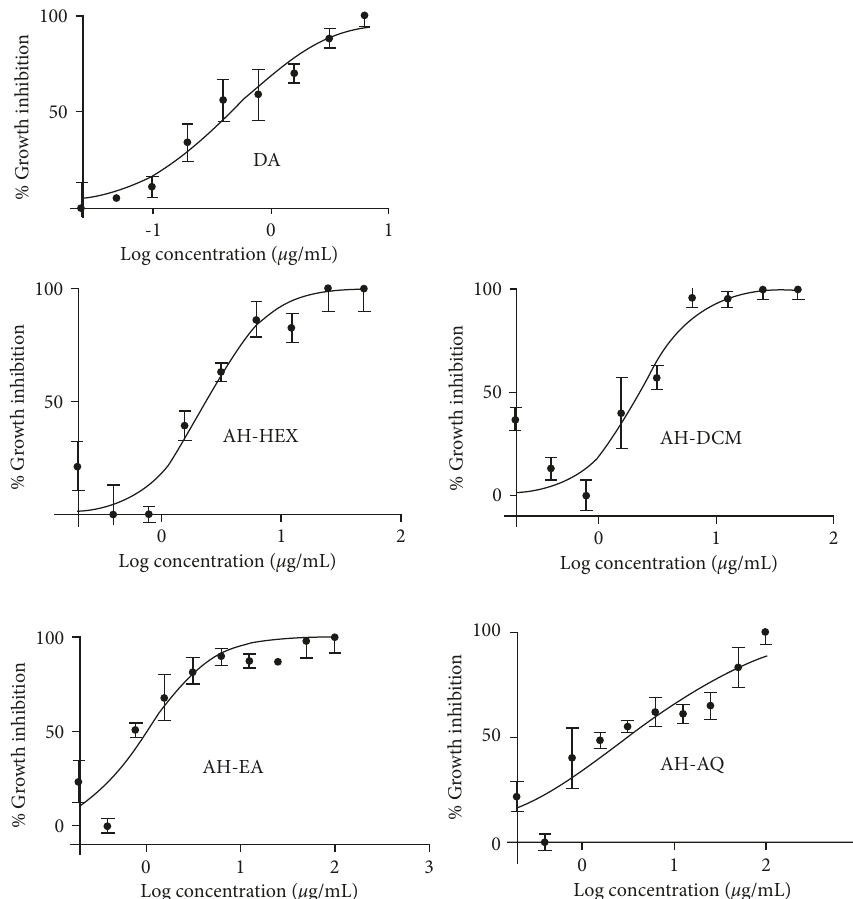
Figure 1: Dose-response curves for fractions of A. hispidum. Dose-response curves and half-maximal effective concentration (EC were modeled by employing a nonlinear regression of the Hill function. Hexane fraction � AH-HEX, Dichloromethane fraction � AH- DCM, ethyl-acetate fraction � AH-EA, aqueous fraction � AH-AQ, DA � diminazene aceturate. Table 1: Antitrypanosomal activities of fractions. Mean EC 50 ( μ g/mL) ± SEM Fractions